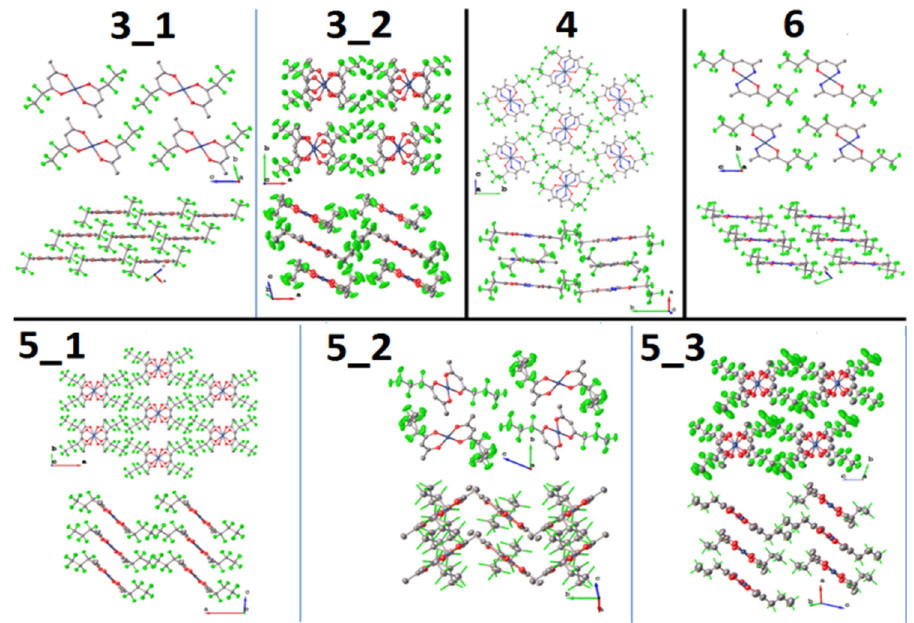
Figure 3. Molecular packing diagrams for the complexes 3 – 6 and their polymorphs.